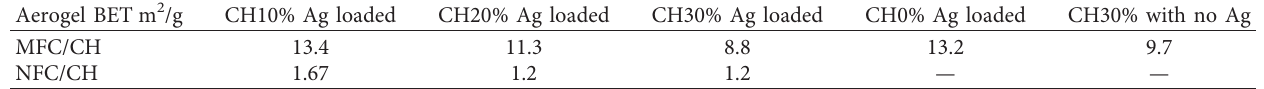
Table 2: BET of both MFC/CH aerogel- and NFC/CH aerogel-loaded Ag-NPs.